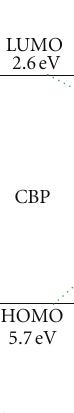
Figure 9: Energy level diagram of the Ir(ppy) 3 green and Ir(piq) 3 red phosphorescent complex doped by the CBP host.